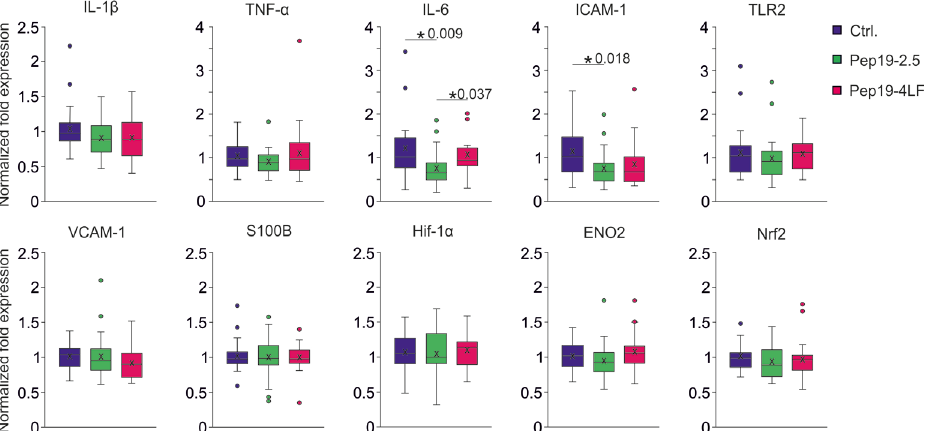
Figure 6. mRNA Expression levels of brain tissue from 4 h after CA-CPR. All results were presented as boxplots showing the quartiles, the 5th and 95th percentiles (whiskers), the median (line) and the mean (x). Normalized expression of each group (n = 6) of cytokines (TNF- α , IL-6, IL1 β ), cell adhesion molecules (ICAM-1, VCAM-1), TLR2, transcription factors (HIF-1 α ; Nrf2), neuron-specific marker (S100B, ENO2 (NSE)). All expression differences were Kruskal-Wallis tested. IL-6 mRNA expression level was lower in the Pep19-2.5 compared to the control ( p = 0.009) as well as the Pep19-4LF group ( p = 0.037). The level of ICAM-1 mRNA expression was lower in the Pep19-2.5 than in the control group ( p = 0.018).